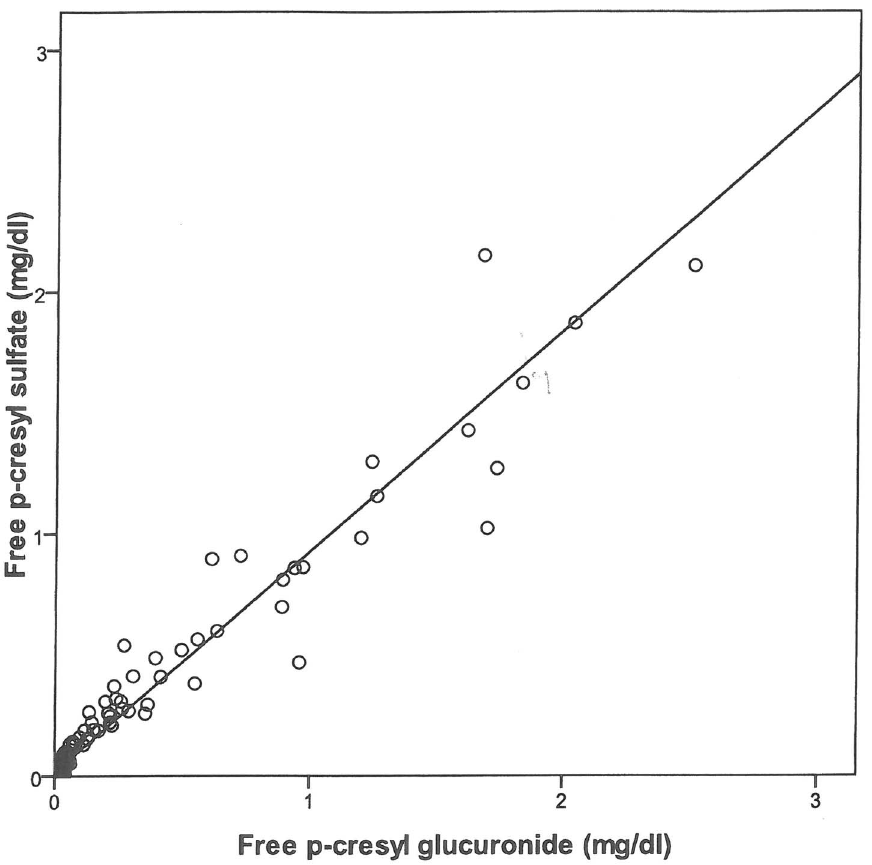
Figure 3. Linear regression curves showing the relationship between free p-cresylglucuronide serum levels and free p-cresylsulfate serum levels; r2=0.95, p , 0.0001.